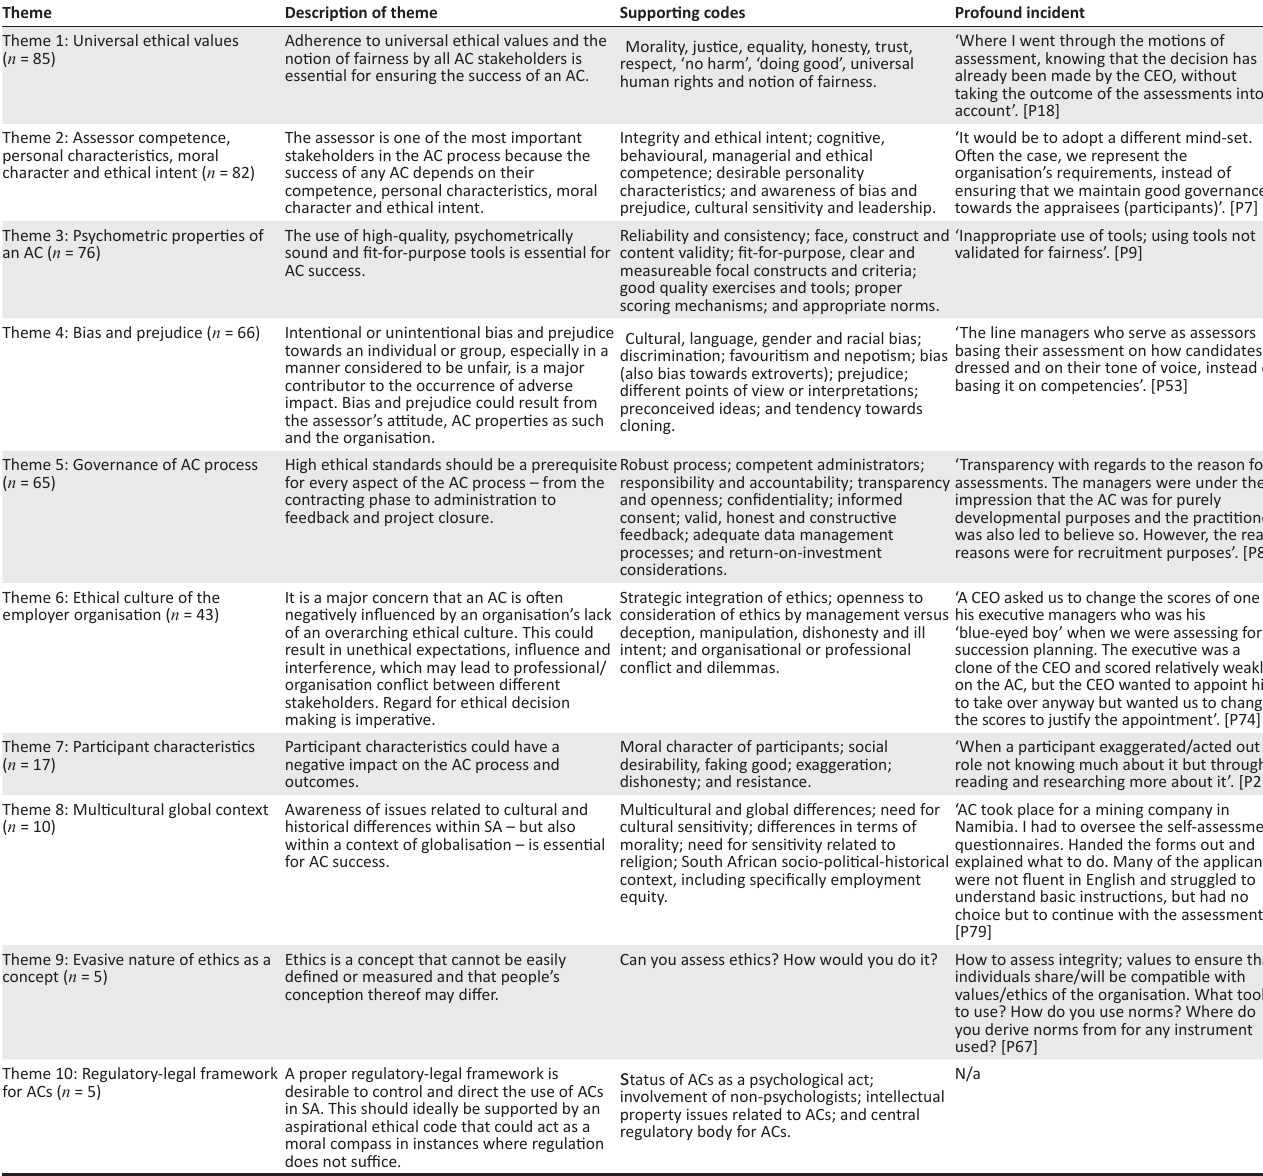
TABLE 1: Ethical challenges faced by assessment centres (ACs) in South